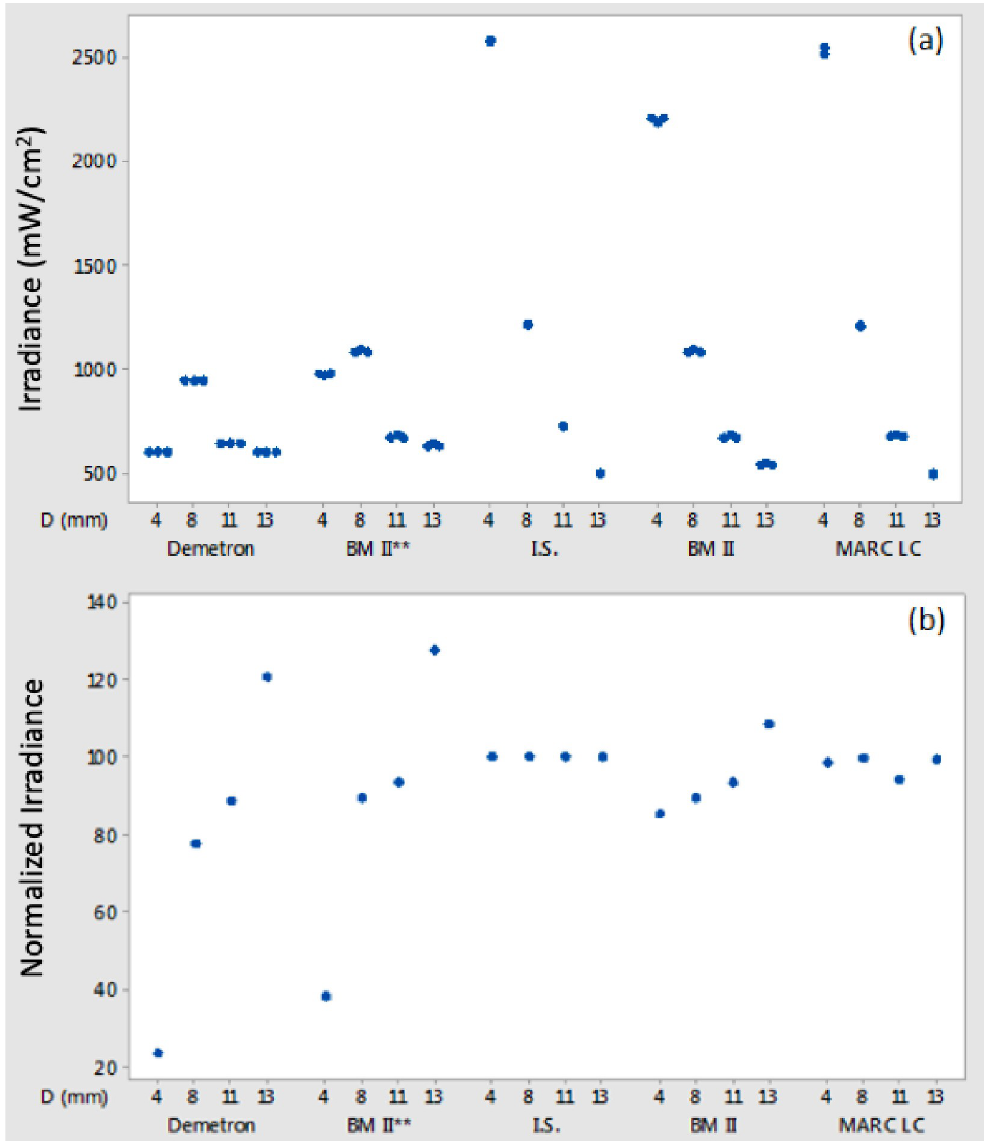
Fig 9. (a) Irradiance values calculated for the four tested guide diameters (D: 4, 8, 11, 13 mm) of the Demetron A2 LED LCU based on power (mW) readings recorded (1) using the integrating sphere fiber-coupled spectro-radiometer gold standard test method (2) the MARC LC instrument and irradiance values recorded using the Demetron L.E.D. radiometer and the BM II sn:1300001150. The BMII instructions for use state that irradiance values may be recorded for light guides between 6 mm and 12 mm diameter and power (mW) values for light guides between 5 mm and 13 mm diameter. A guide with mm increments between 6 mm and 12 mm is provided on the instrument base to allow guide tip diameter measurements for programming irradiance values from power (mW) measurements. The graph displays the raw data ( �� ) irradiance values for this instrument, as recorded for the four light guides used with the Demetron A2 and the recalculated values for the 4 mm and 13 mm tips. The latter were based on the increase in area (from 4 mm to 6 mm diameter) or decrease in the area (from 13 mm to 12 mm) between the actual guide diameter tested and the programmed instrument software input based on using the nearest available guide diameter. Note how, when this is done, the BM II data approaches the GS results and how the MARC LC data is in close accord to the GS data set. The results confirm the value of using a meter light sensor area larger than any tested light source exit window area. (b) The same data as Fig 7A normalized relative to the mean integrating sphere (100%) gold standard